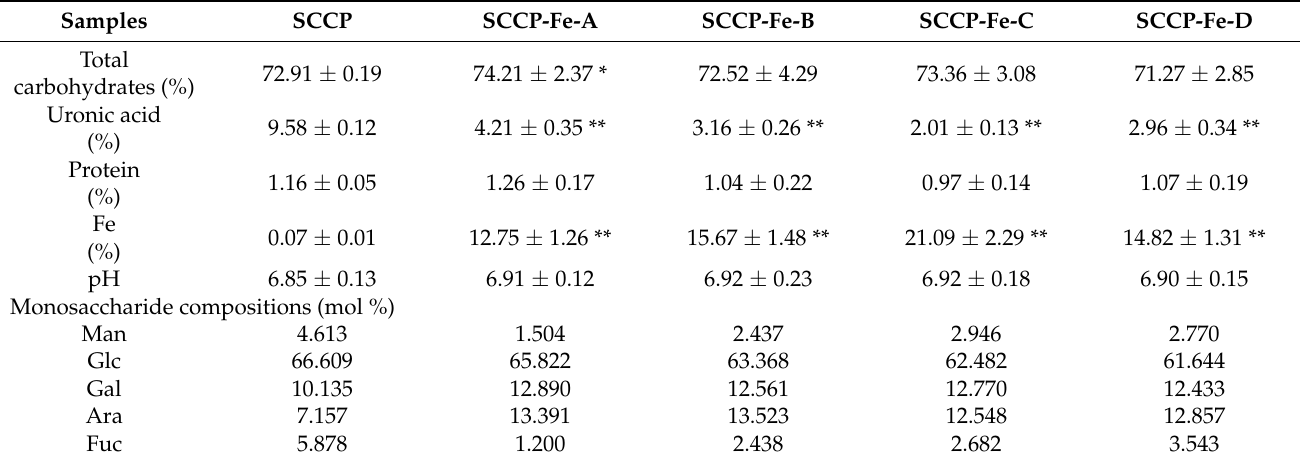
Table 1. Chemical and monosaccharide compositions of